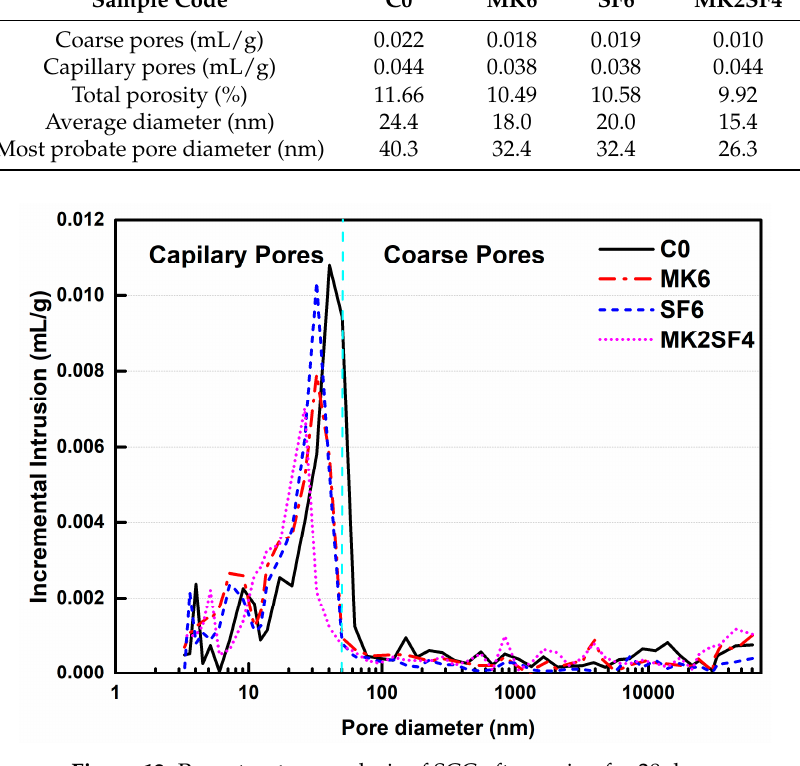
Figure 12. Pore structure analysis of SCC after curing for 28 days.